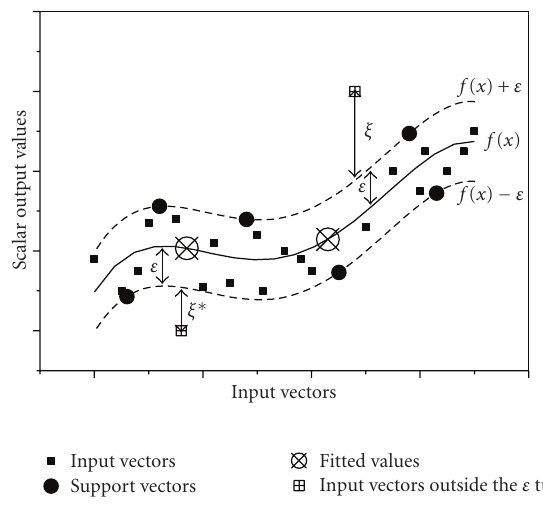
Figure 1: The schematic illustration of the SVR using ε -insensitive cost function